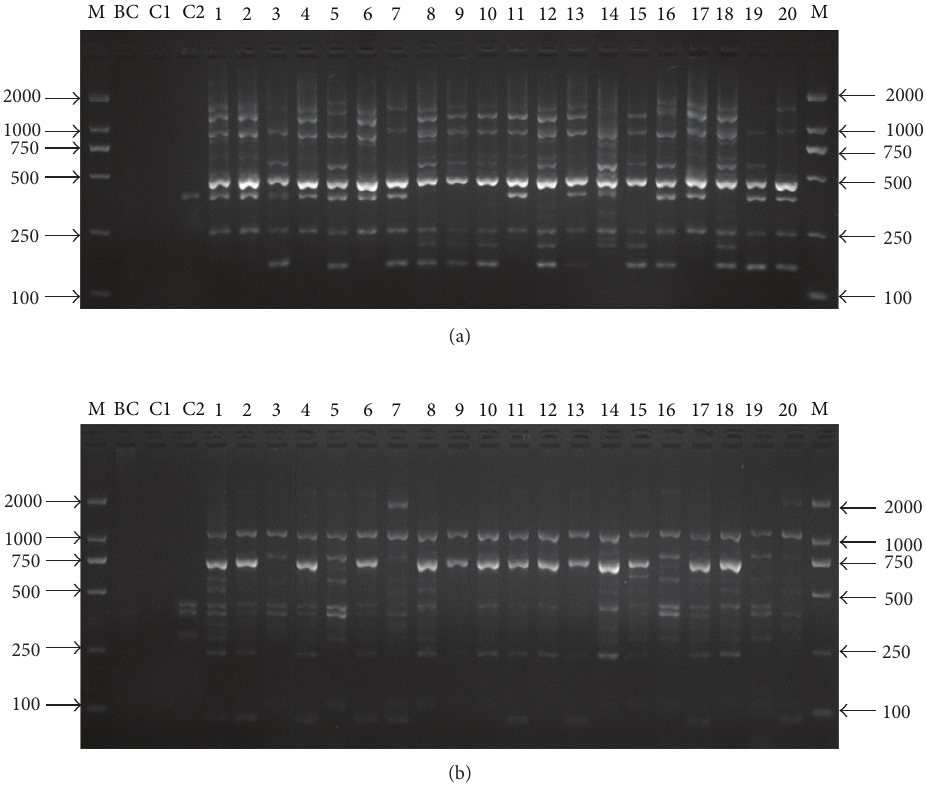
Figure 1: Fragment profiles of Hypsizygus marmoreus generated by primer combination of TRAP. ((a) EU94L1-EM9, (b) GQ76R1-ME1, BC, C1, and C2 correspond to blank control, no primers, and Coprinus comatus ; the spots from 1 to 20 correspond to the strains of H. marmoreus (see Supplementary Table